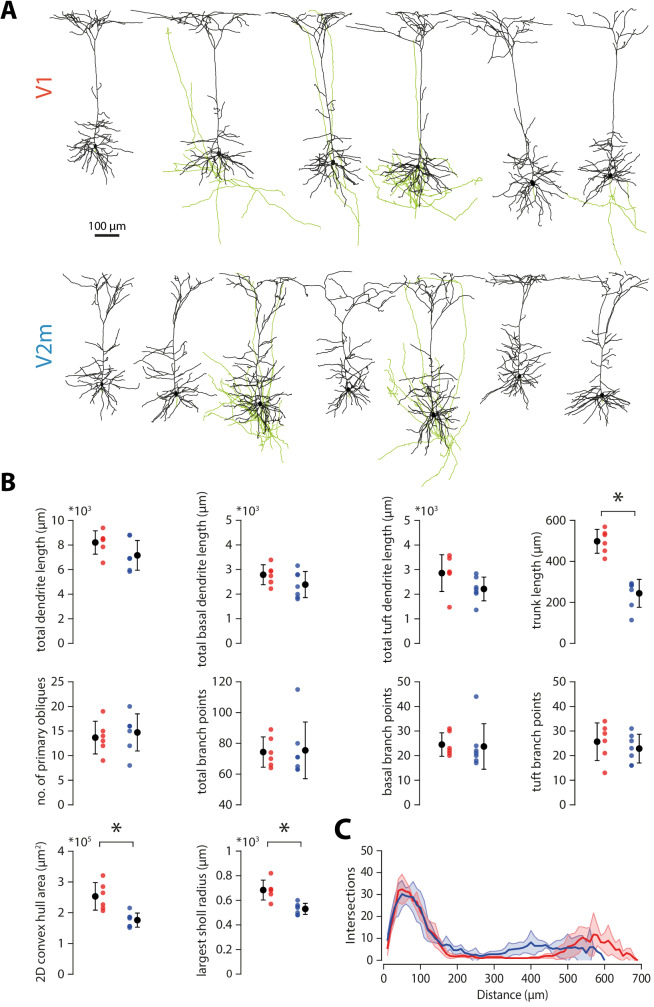
Reconstructions and morphological analysis of V1 and V2m neurons.(A) Full reconstructions of 6 neurons in V1 (top) and 7 neurons in V2m (bottom), labelled with CTB and filled with biocytin during recordings. Black: dendrites and soma. Green: axons. (B) Quantification of morphological parameters from the reconstructed neurons shown in A. Asterisk denotes p < 0.005 Bonferroni-corrected two-sample t-test. (C) Sholl analysis, showing number of dendritic intersections with concentric spheres in 10 μm increments from the soma.